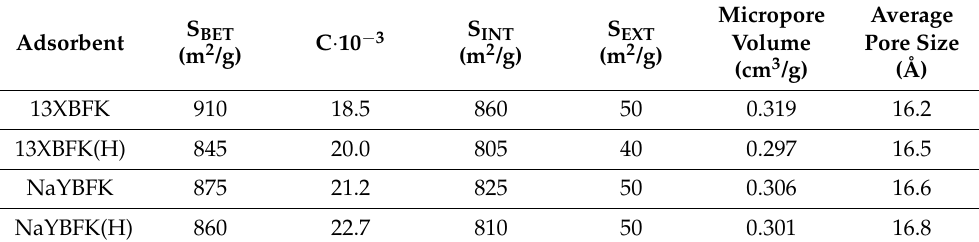
Table 2. Textural parameters of 13XBFK, 13XBFK(H), NaYBFK and NaYBFK(H).